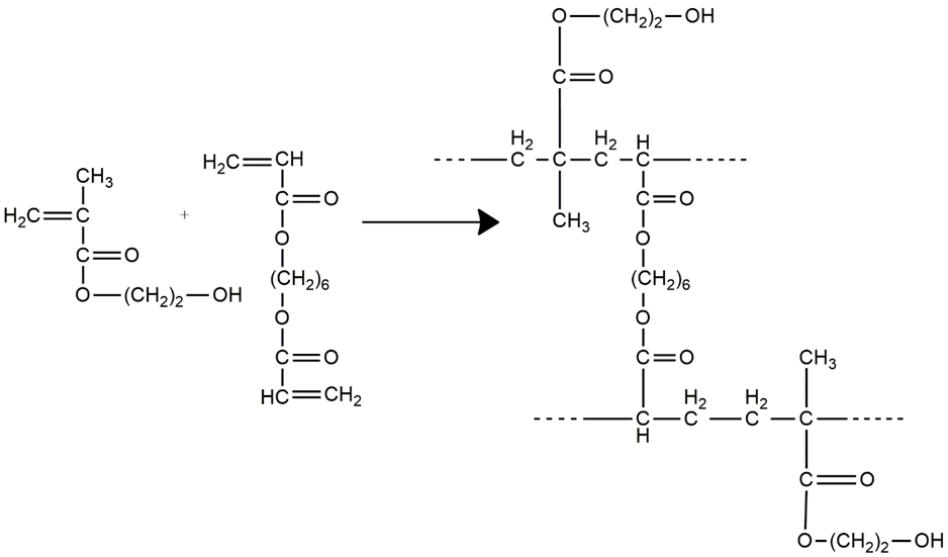
Figure 3. Schematic representation of HEMA crosslinking by HDDA.